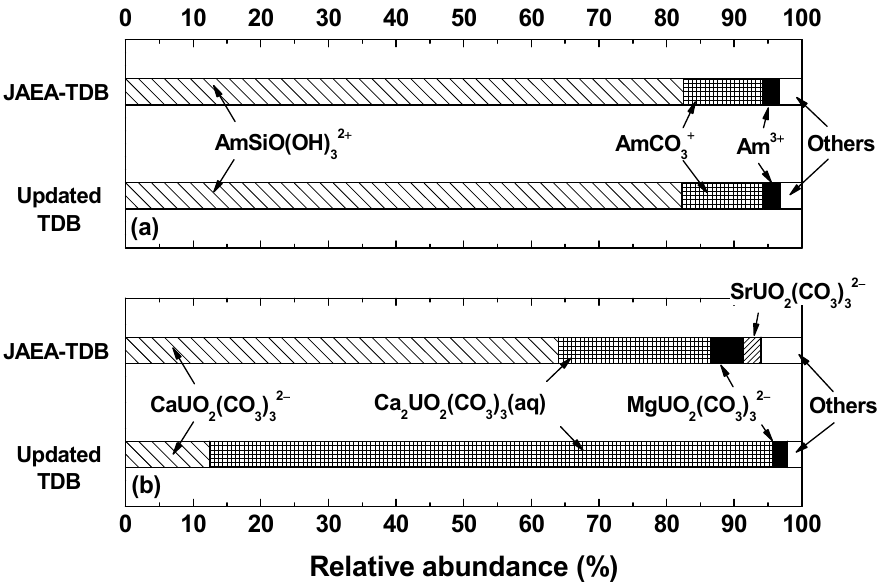
Figure 2. Relative distribution of aqueous ( a ) Am and ( b ) U species predicted by using JAEA-TDB and updated TDB, respectively. Chemical species less than 2% in their abundances are merged as “others”.